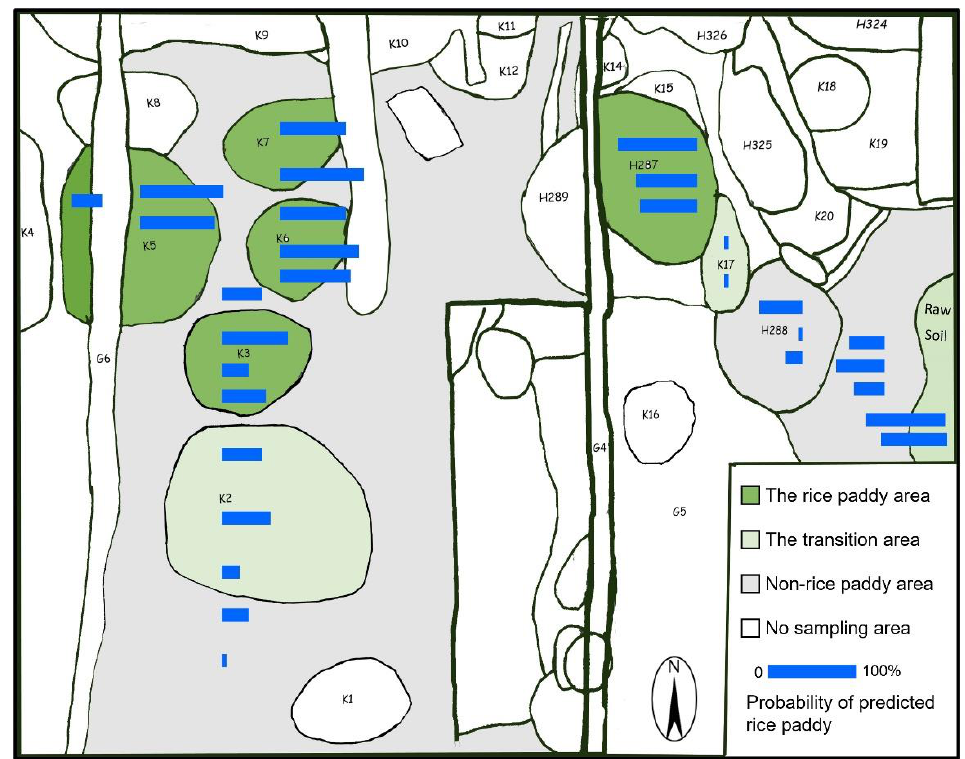
Figure 7. Preliminary structural view of the rice paddy field identified at Zhangwangzhuang.